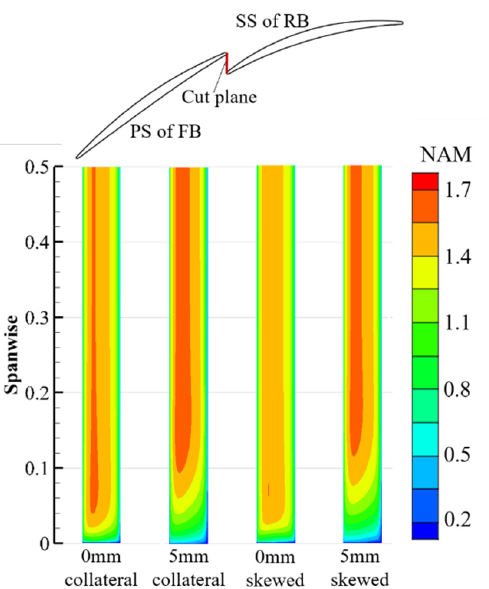
Figure 16. The gap flow normalized axial momentum under different IBL conditions.